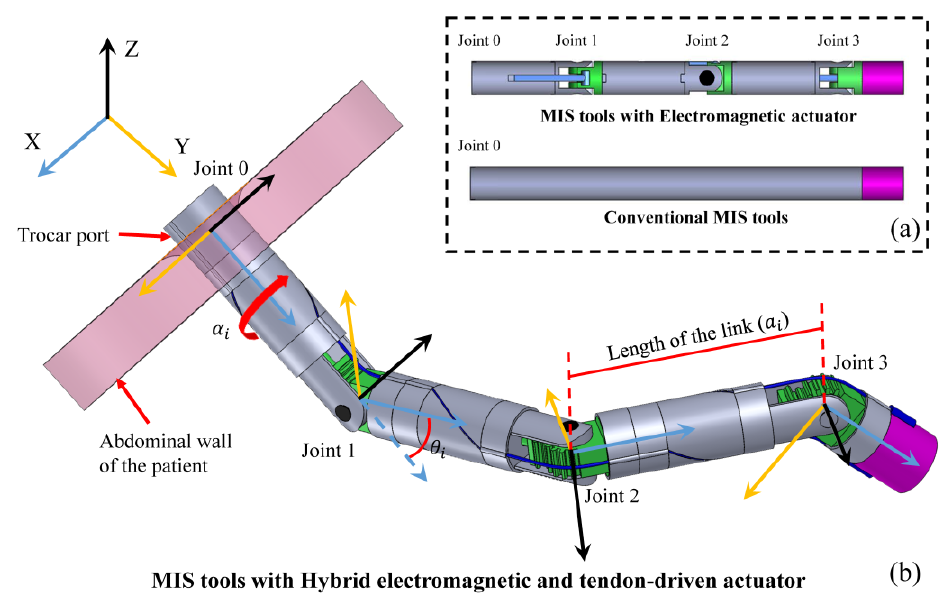
Figure 3. Links and joints of the MIS tools for kinematic analysis. ( a ) Conventional MIS tools and MIS tools with the electromagnetic actuator. ( b ) MIS tools with hybrid electromagnetic and tendon-driven actuator.